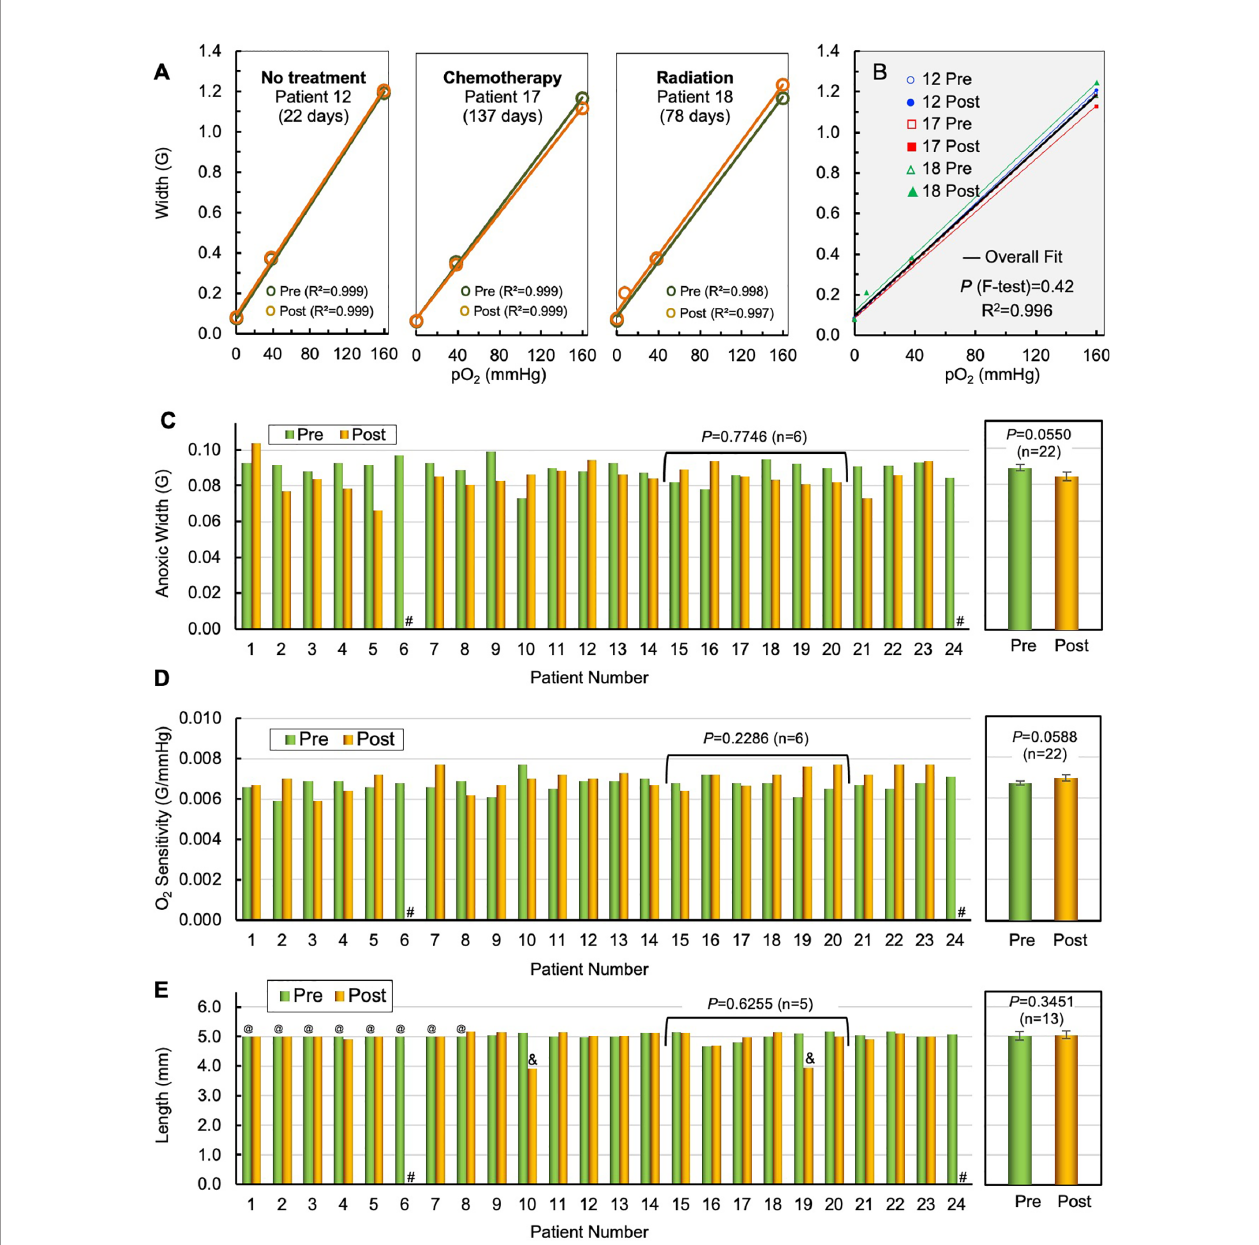
FIGURE 3 | Stability of OxyChip implant and function in tumors — during residency and treatment. The stability of the OxyChip for long-term monitoring of pO 2 in a variety of human tumors, implant-periods, and treatments was evaluated by checking pre/post calibration of their oxygen sensitivity and structural integrity (morphology) of the implant. Representative calibration data include OxyChips removed after: (A) 22 days in an untreated SCC (patient 12); 137 days in a breast tumor (IDC) treated with chemotherapy (patient 17); and 78 days in a sarcoma (patient 18) treated with radiation. There were no apparent changes in the calibrations including linearity between pre- and explanted OxyChips. (B) F-test and overall fi t of all three pre- and post-implant OxyChips do not show any statistically signi fi cant differences in their calibration. (C) EPR spectral width of pre- and post-implant OxyChips under anoxic condition (Anoxic Width). # Lost OxyChip. There was no overall signi fi cant difference in the anoxic width between the pre- and explanted OxyChips (22 OxyChips, mean ± SEM, paired t-test, P =0.0550). There were also no signi fi cant differences among the OxyChips from patients 15 – 20 that underwent chemo- or radiation therapy during implant (paired t-test, P =0.7746; n=6). (D) Pre- and post-implant oxygen sensitivity of each OxyChip. # Lost OxyChip. There was no overall signi fi cant difference in the oxygen sensitivity between the pre- and explanted OxyChips (22 OxyChips, mean ± SEM, paired t-test, P =0.0588). There were also no signi fi cant differences among the oxygen sensitivity of the OxyChips from patients 15 – 20 that underwent chemo- or radiation therapy during implant (paired t-test, P =0.2286; n=6). (E) Pre- and post-implant length of OxyChips. There were no overall signi fi cant differences between the pre- and post-implant OxyChips (13 OxyChips, mean ± SEM, paired t-test, P =0.3452). There were also no signi fi cant differences among the OxyChips from patients 15 – 20 (patient 19 excluded) that underwent chemo- or radiation therapy during implant (paired t-test, P =0.6255; n=5). Key: # Lost OxyChip; @ Made to 5-mm length, but not measured before implantation; & Possibly cut during